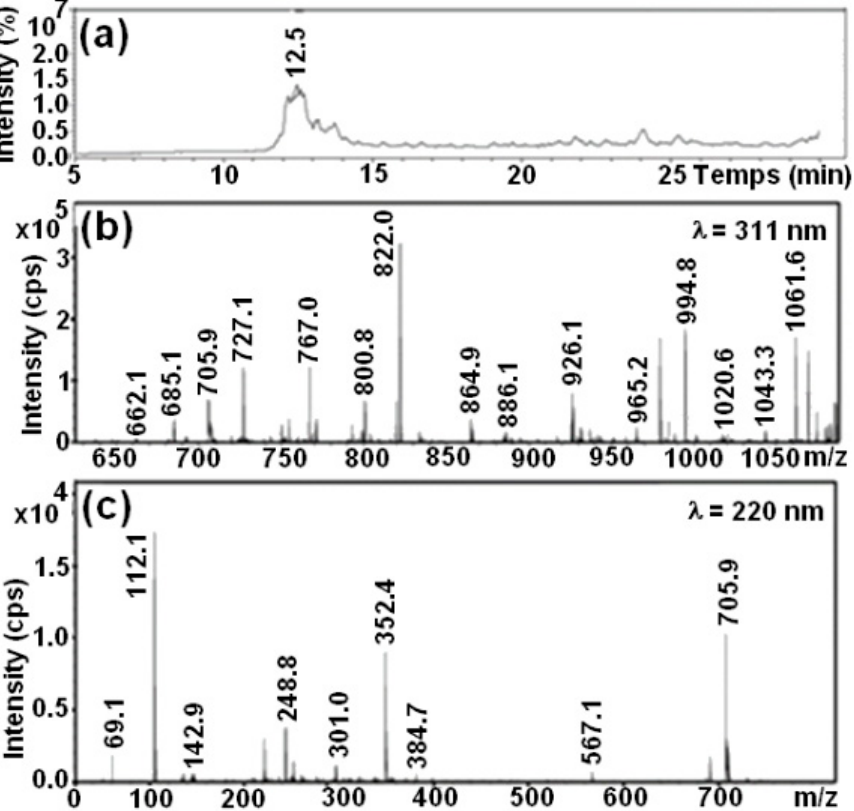
Figure 10. ( a ) HPLC profile of RB5 dye solution. Mass spectrums of peaks from 10.5 min at ( b ) λ = 311 nm and ( c ) λ = 220 nm.